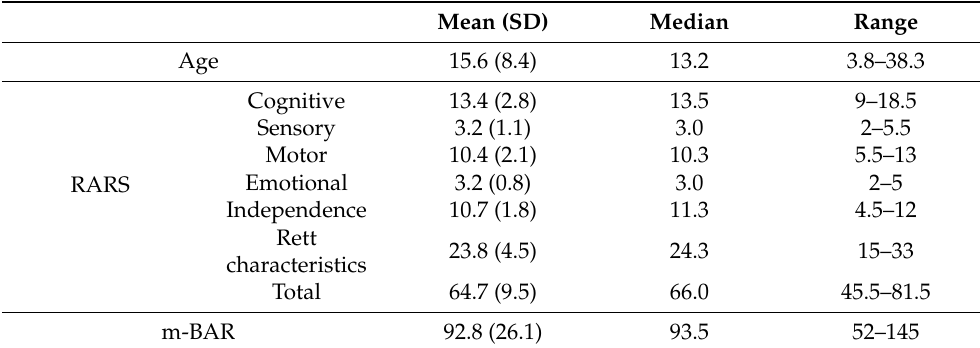
Table 1. Descriptive statistics of participants’ ages, RARS total and subscale scores, and m-BAR